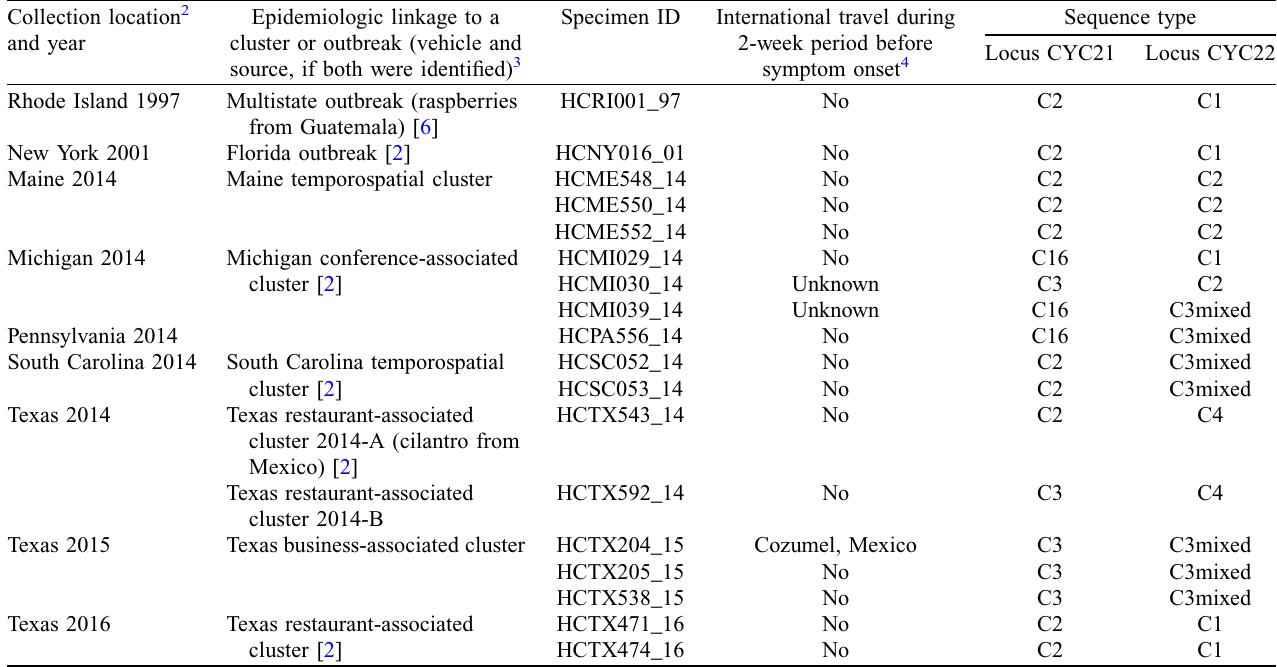
Table 3. Epidemiologic information 1 and typing results for 18 stool specimens (with typing data for both loci CYC21 and CYC22) from 18 patients associated with case clusters or